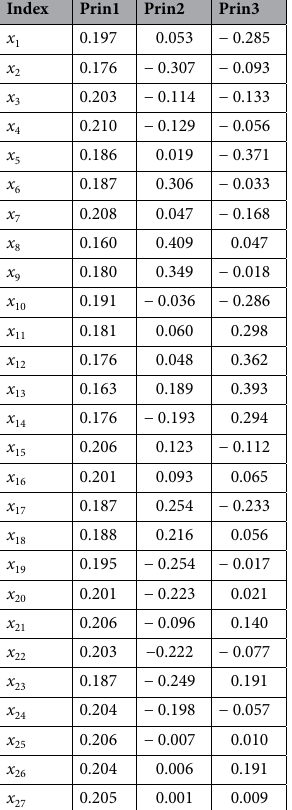
Table 7. Eigenvalues of the indices under the three principal components.